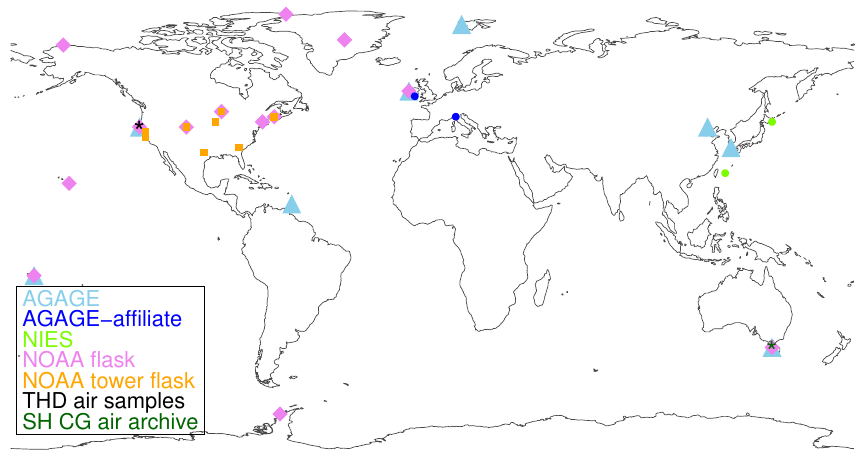
Fig. 1. Sampling networks and locations for the measurements used in the HCFC-22 inversions. See also Table 1.